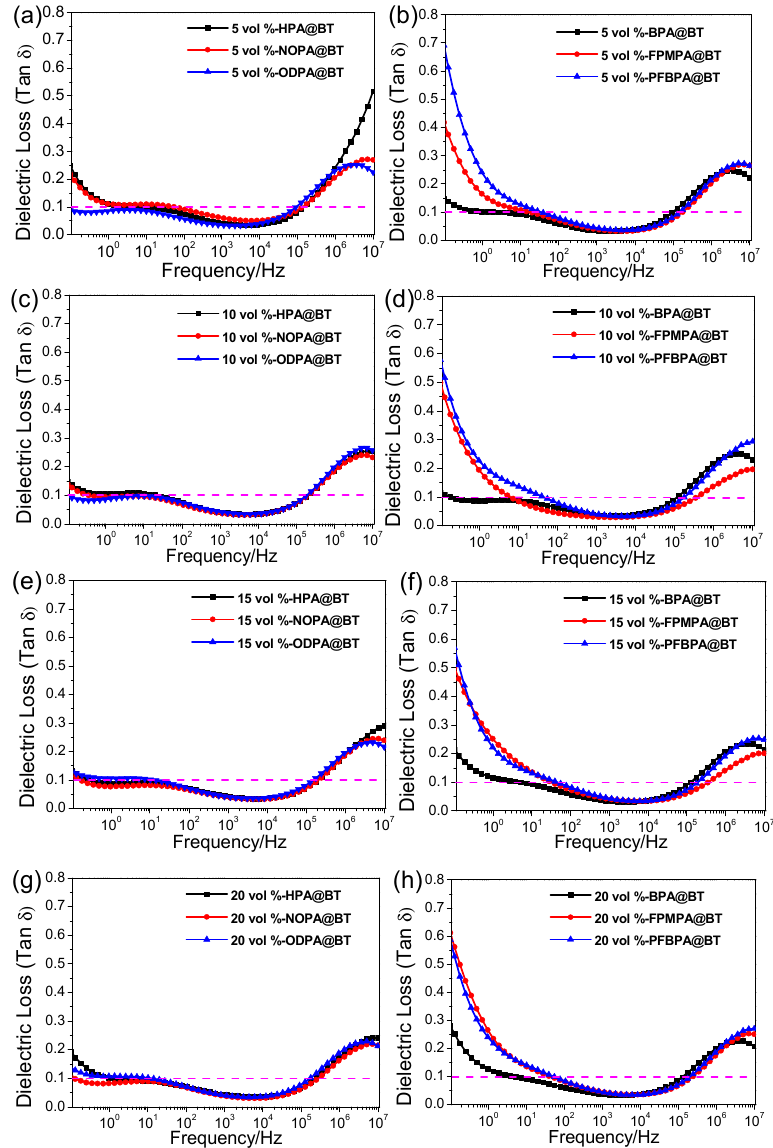
Figure 3. Frequency dependence of the dielectric loss of the P(VDF-HFP) nanocomposite films with different volume fractions of modified BT ( a – h